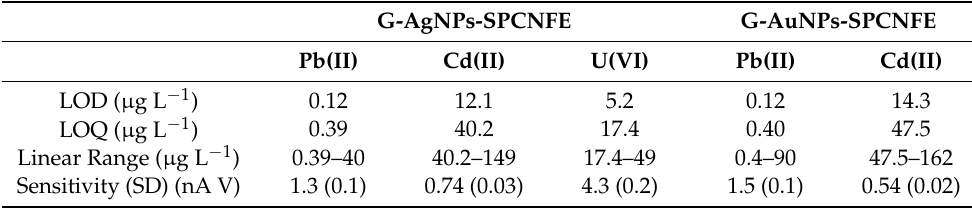
Table 2. Analytical parameters obtained for G-Ag-NPs and G-Au-NPs modified